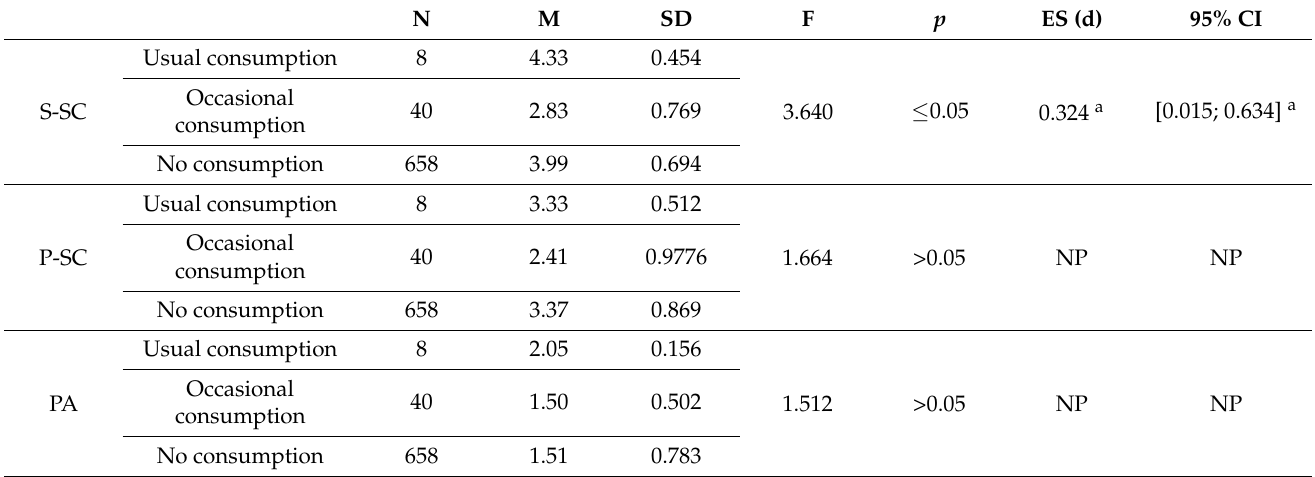
Table 3. Comparative analysis of cannabis